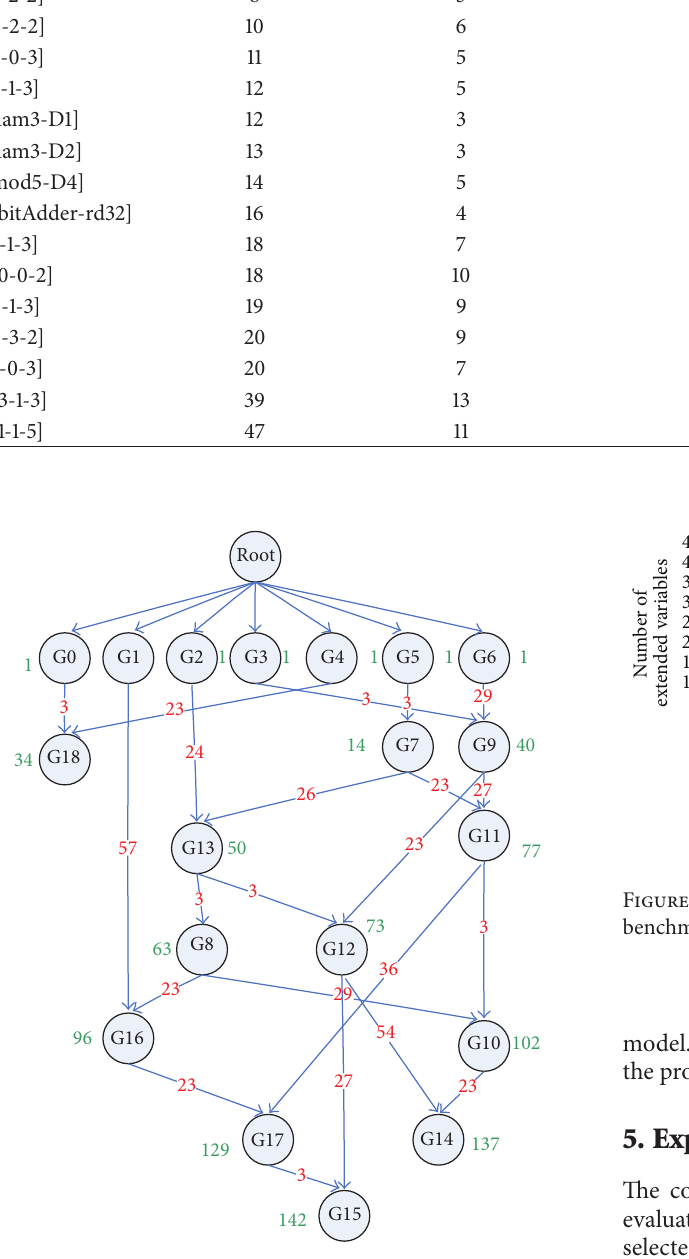
Figure 6: Dataflow graph of the example based on the proposed model.